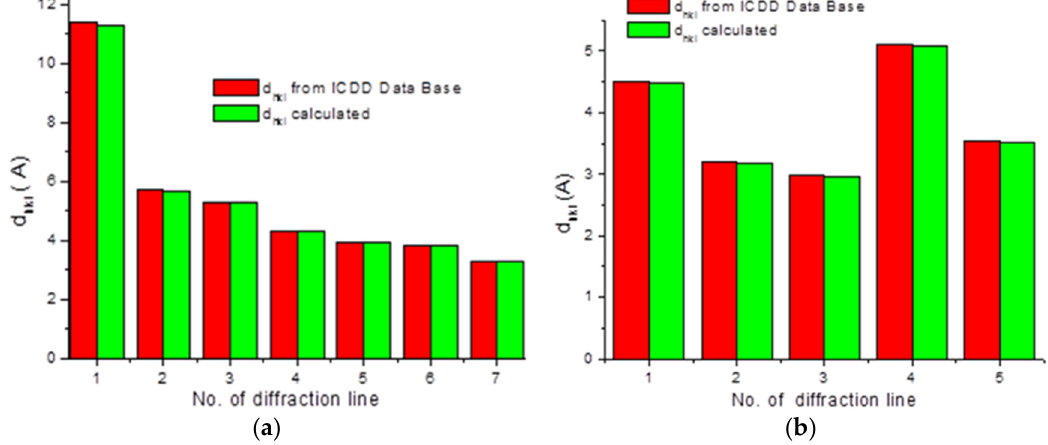
Figure 12. Comparison of calculated values of d hkl with values found in the ICDD Data Base: ( a ) Aspirin ® (Bayer); ( b ) vitamin C (Apteo).